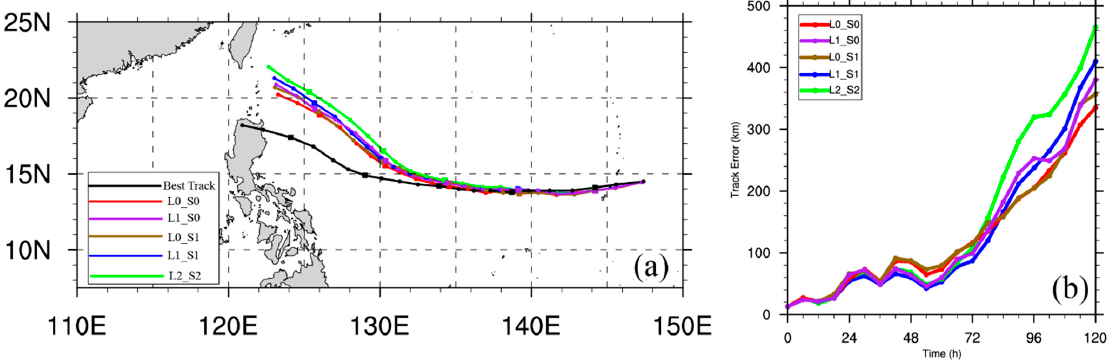
Figure 9. The TC tracks ( a ) and track errors ( b ) simulated by different experiments. The squares represent the central location of the TC at 0000 UTC.